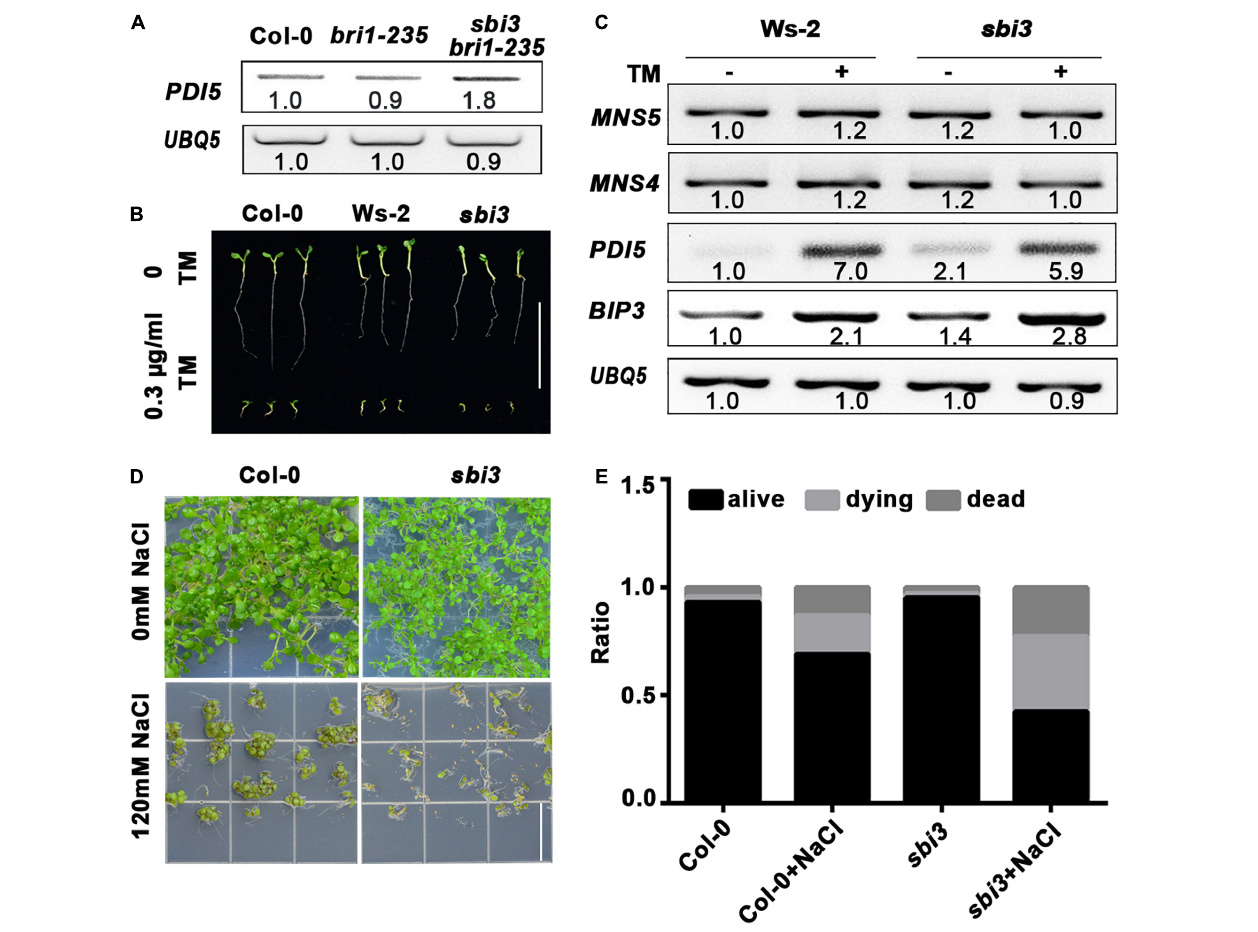
FIGURE 6 | sbi3 exists UPR and is less tolerant to TM and salt. (A) Reverse transcription PCR (RT-PCR) analysis of PDI5 in Col-0, bri1-235, and sbi3 bri1-235 , UBQ5 served as a control. (B) Comparison of 7-day-old seedlings of wild type and sbi3 mutant grown in 1 / 2 MS with or without 0.3 µ g /mL TM. Scale bar = 1 cm. (C) Expression levels of MNS5 , MNS4 , PDI5, and BIP3 in Ws-2 and sbi3 with or without 5 µ g/mL TM for 6 h. UBQ5 served as a control. (D) The photograph of 12-day-old seedlings grown in 1 / 2 MS with or without 120 mM NaCl. Scale bar = 1.5 cm. (E) The ratio of the seedlings was shown in the bar graphs, alive (black), dying (light gray), dead (dark gray). These experiments were repeated three